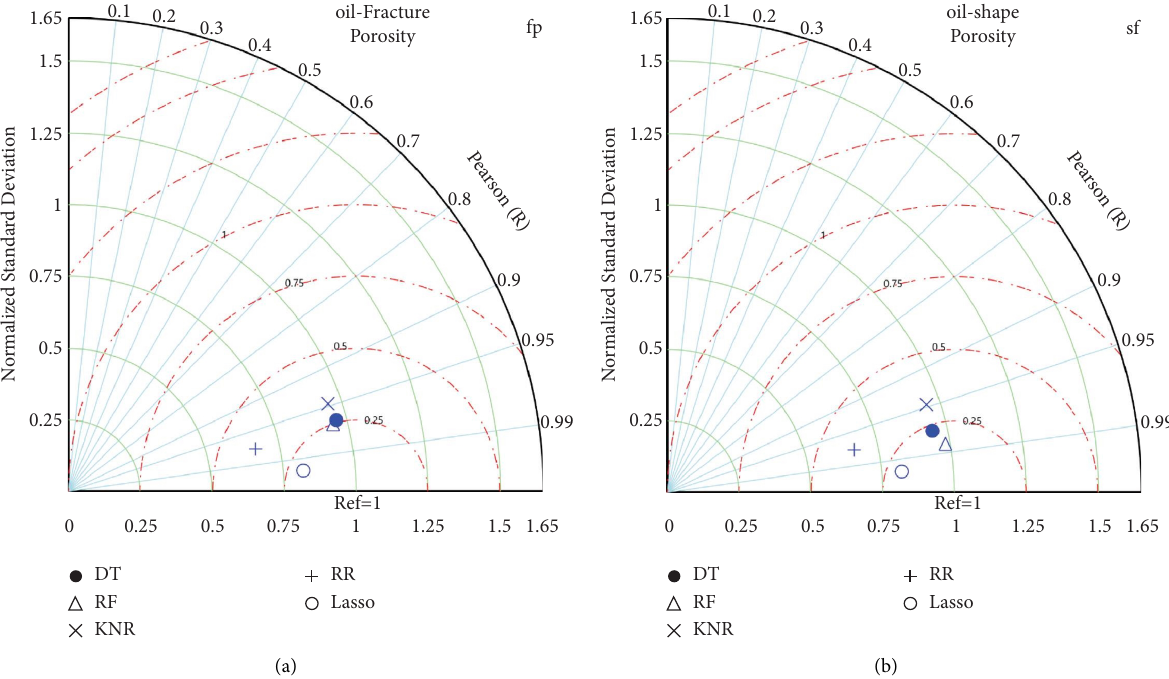
Figure 14: Taylor diagram presentation for the oil fow fracture porosity and shape factor prediction using diferent machine learning